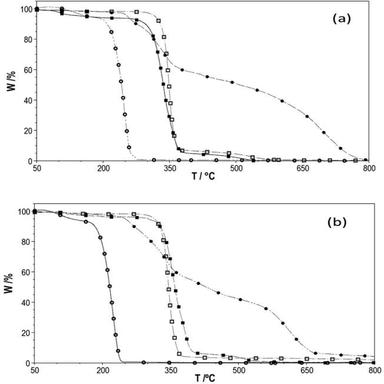
TG curves obtained under air (a) and N2 (b) atmospheres of the selected ILs at 10 C min1 : s, h, j, .